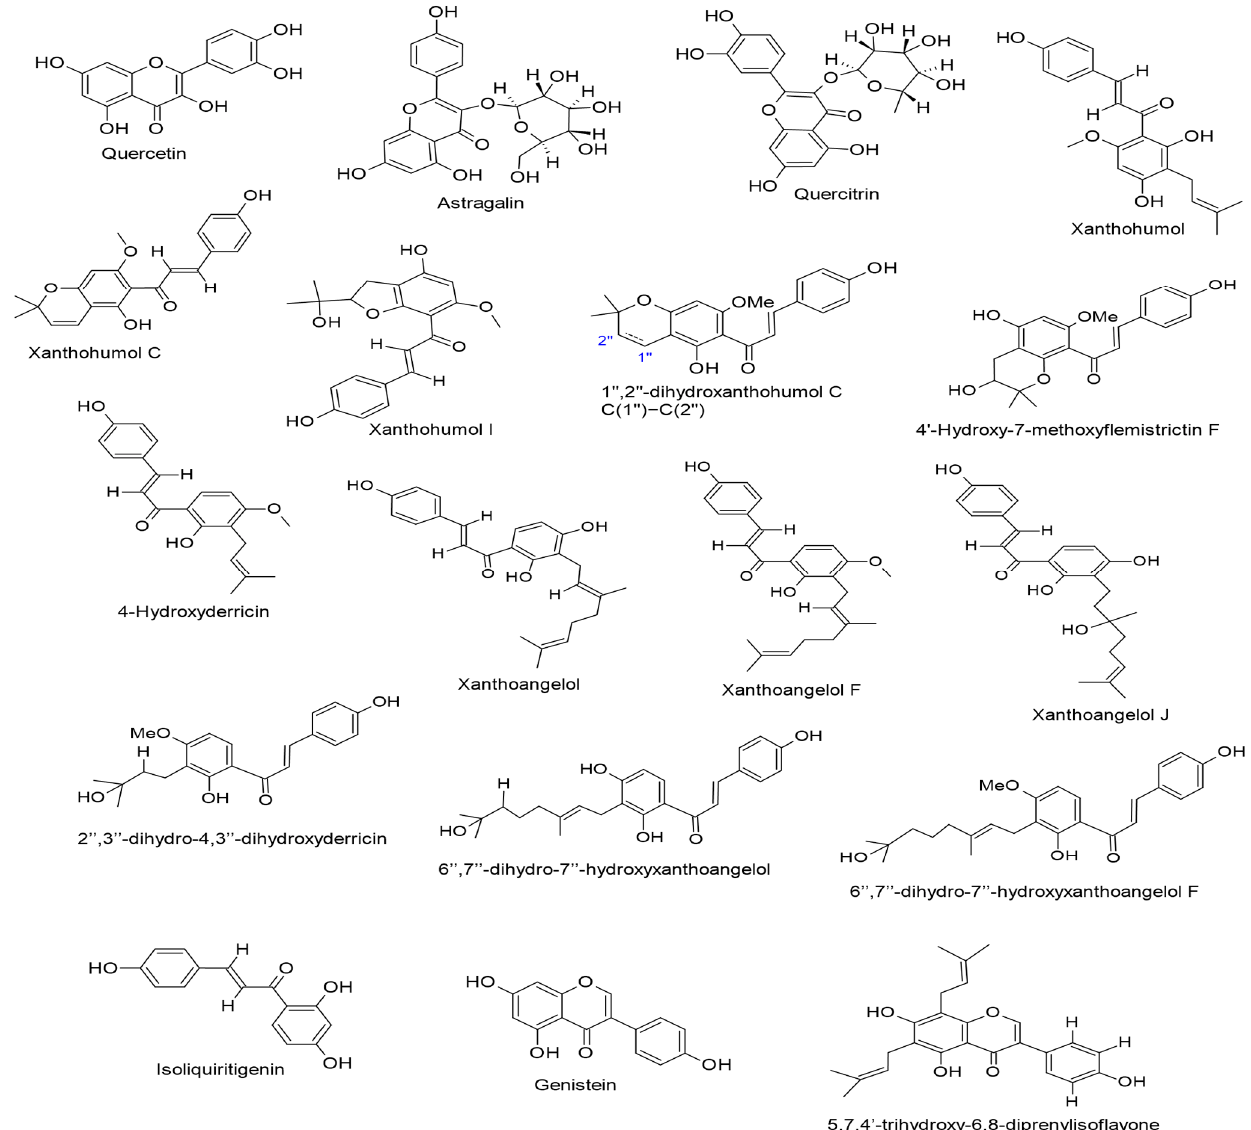
Figure 2. Chemical structures of flavonoids (flavones, protoflavones, isoflavones, flavanones, catechins, flavonols, and chalcones) with inhibitory activities against Epstein–Barr virus (EBV). EBV-LMP1 is known to promote cell proliferation and progression of NPC cells